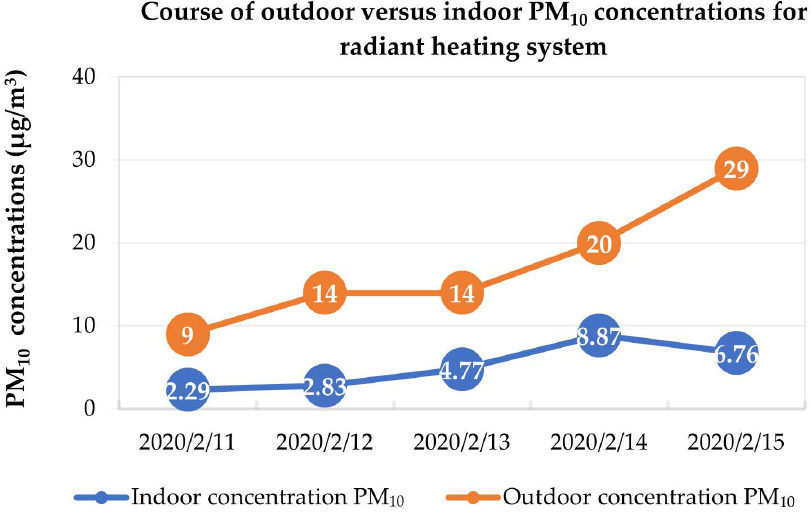
Figure 17. Courses of outdoor versus indoor PM 10 concentrations for RHS